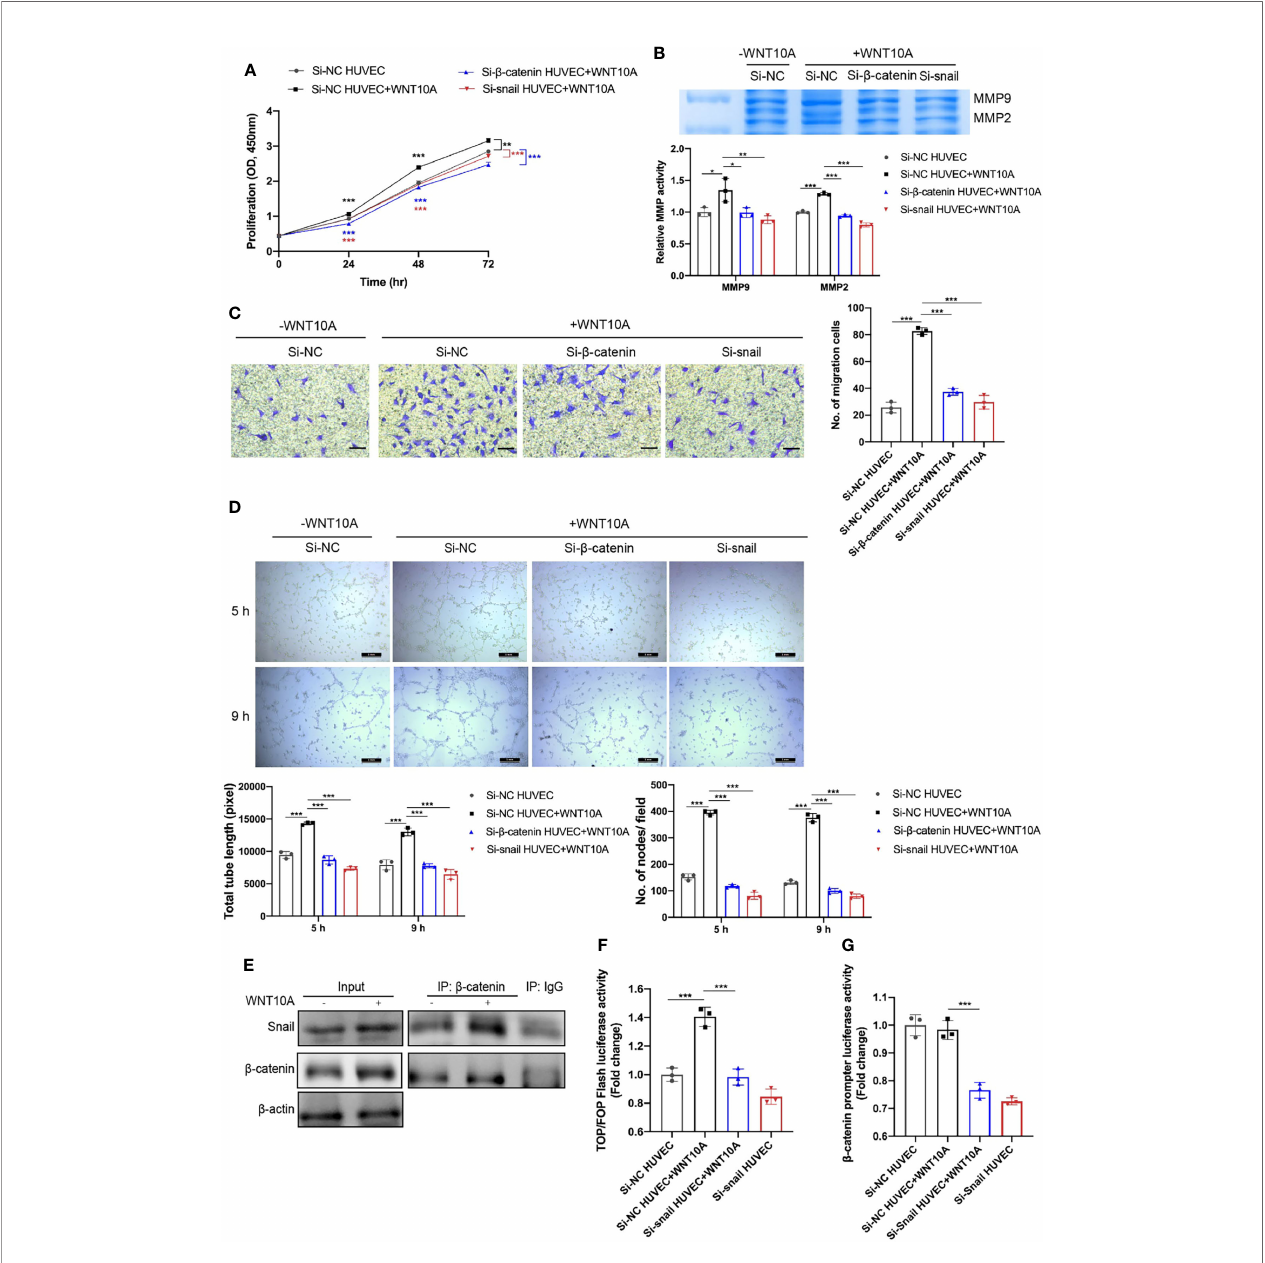
FIGURE 6 | b -catenin and snail participated in WNT10A-induced proliferation, ECM degradation, migration, and tube formation ability, and b -catenin interacted with snail. (A – D) Cell proliferation (A) , MMP2/9 activity (B) , migration ability (C) , and tube formation ability (D) of HUVECs were evaluated by CCK-8 assay, gelatin zymography, transwell migration assay, and tube formation assay, respectively. HUVECs were transfected with negative control siRNA, b -catenin siRNA, or snail siRNA before WNT10A treatment. Scale bar, 200 m m. (E) Co-IP analysis showed the interaction between b -catenin and snail in HUVECs. b -catenin and snail were immunoprecipitated by antibodies against b -catenin. Antibody against IgG was used as a negative control. (F) b -Catenin transcriptional activity in control HUVECs and snail-silenced HUVECs were analyzed by Top/FopFlash reporter assay. (G) Activity of b -catenin promoter in control HUVECs and snail-silenced HUVECs were analyzed by dual-luciferase reporter assay. Error bars, SD; n = 3 independent experiments; * p < 0.05, ** p < 0.01, *** p < 0.001. ECM, extracellular matrix; HUVEC, human umbilical vein endothelial cell; CCK-8, Cell Counting Kit-8; Co-IP,